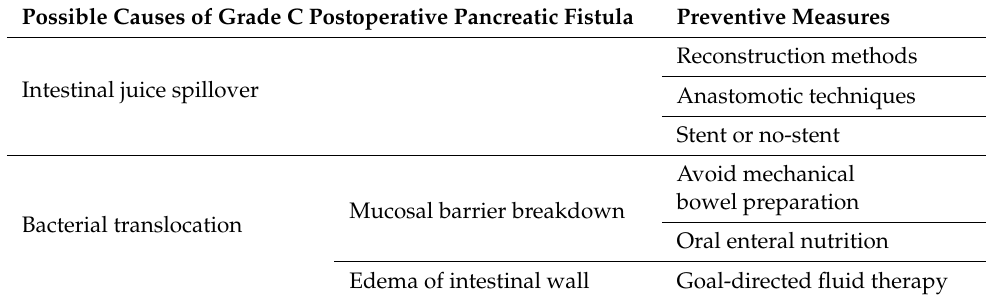
Table 1. Possible causes of grade C postoperative pancreatic fistula and corresponding preventive